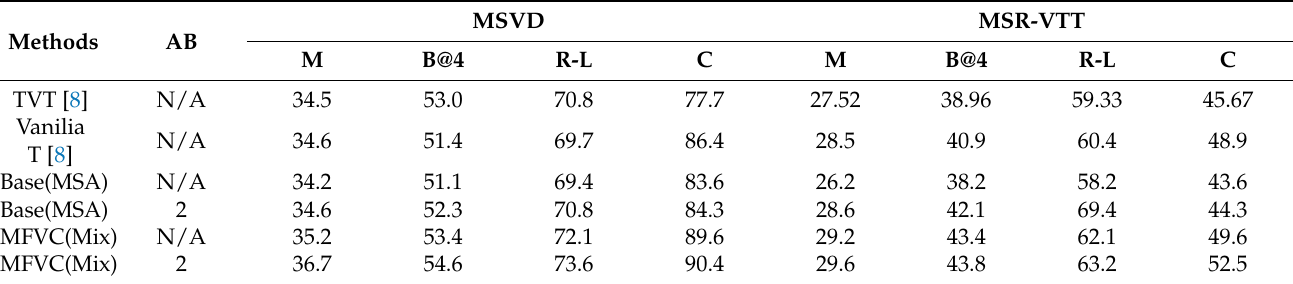
Table 4. Ablation test results on MSVD and MSR-VTT test